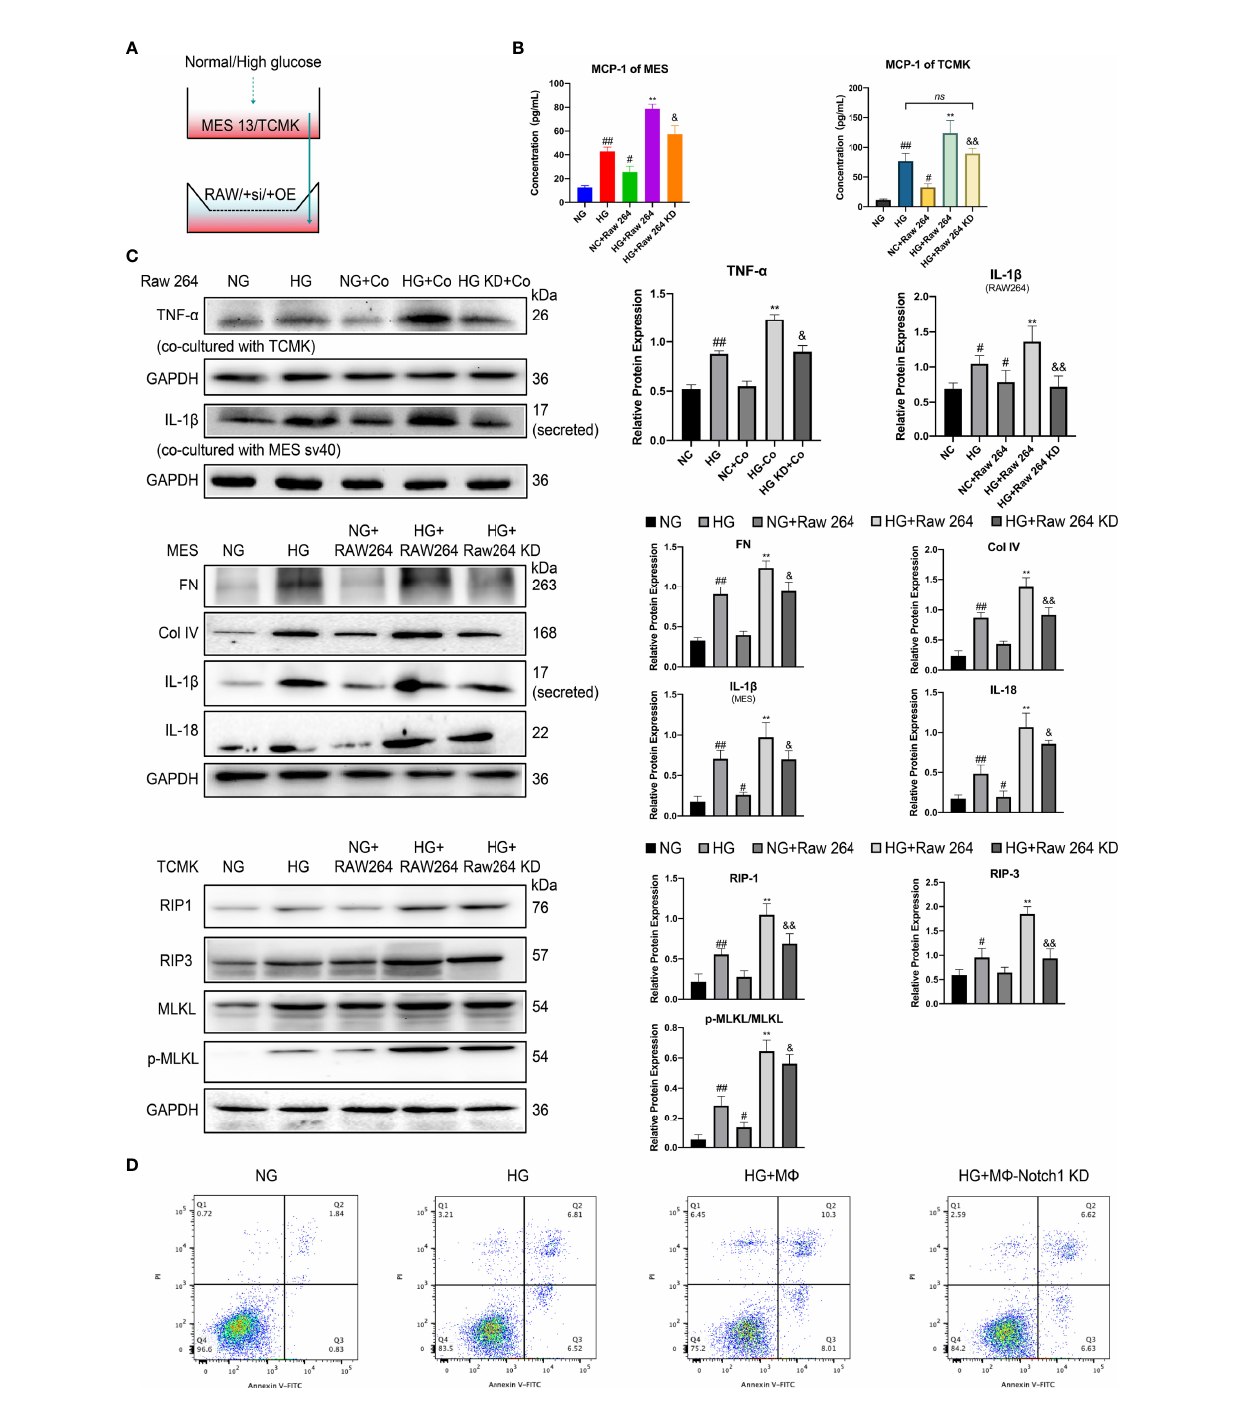
FIGURE 8 | Coculture of macrophages and intrinsic renal cells under high glucose condition signi fi cantly aggravates in fl ammation, fi brosis, and necroptosis of intrinsic renal cells. (A) Schematic of the coculture experiments. (B) The concentration of MCP-1 in the supernatants of different group cells was determined by ELISA. (C) Western blot and semiquantitative analyses. (D) Cell death was assessed by Annexin V-FITC/PI staining and analyzed by fl ow cytometry. NG, normal glucose; HG, high glucose; KD, knockdown; OE, over expression; Co, coculture. # p < 0.05 vs. the normal glucose (NG) group, ## p < 0.01 vs. the normal glucose (NG) group, **p < 0.01 vs. the high-glucose (HG) group, & p < 0.05 vs. the high-glucose coculture group, && p < 0.01 vs. the high-glucose coculture group. ns, no signi fi